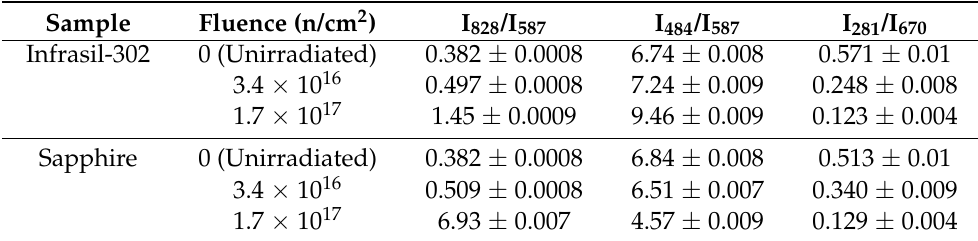
Figure 5. Gamma dose dependence of ( a ) intensity ratio of 828 nm Xe I line and 587 nm He I line; ( b ) intensity ratio of 484 nm Xe II line and 587 nm He I line; and ( c ) intensity ratio of 281 nm Eu I line and 670 nm Li I line. Table 2. Neutron fluence dependence of the line intensity